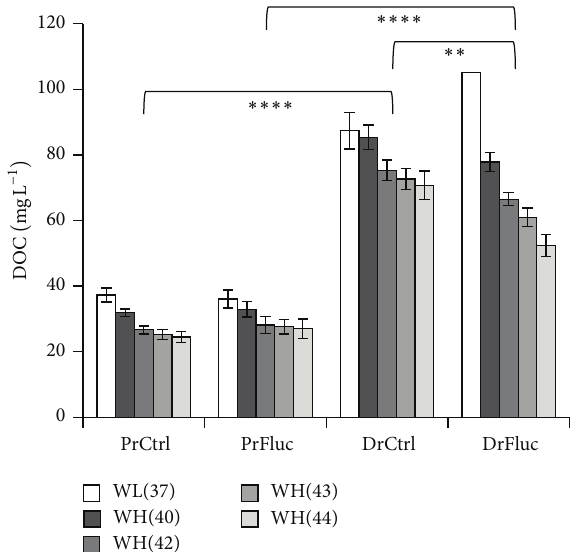
Figure 2: Mean ( ± SE) concentrations of DOC in different exper- imental groups at phase WL(37) and phases WH(40–44). 𝑁 = 5 for each experimental group and each phase except for DrFluc at phaseWL(37),where 𝑛 = 1 .ForstatisticaltestsonlyphasesWH(40– 44) were included. Significant differences between the experiment groups are indicated with asterisks ( ∗∗ 𝑃 < 0.01 ; ∗∗∗∗ 𝑃 < 0.0001 ). W: water sampling; L: low water table; H: high water table; (xx): calendar week number. Pr: pristine; Dr: drained; Ctrl: control; Fluc: fluctuating water table.